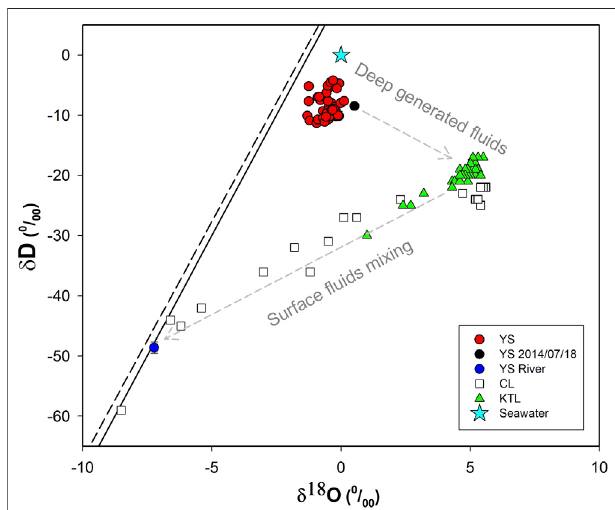
FIGURE 6 | Plot of δ D and δ 18 O for groundwater samples in this study with literature results of CL and KTL for comparison (Chan, 2001). Seawater composition,localmeteoricwaterline(Wangetal.,2001;solidline),andglobal meteoric water line (Craig, 1961; dash line) are shown for